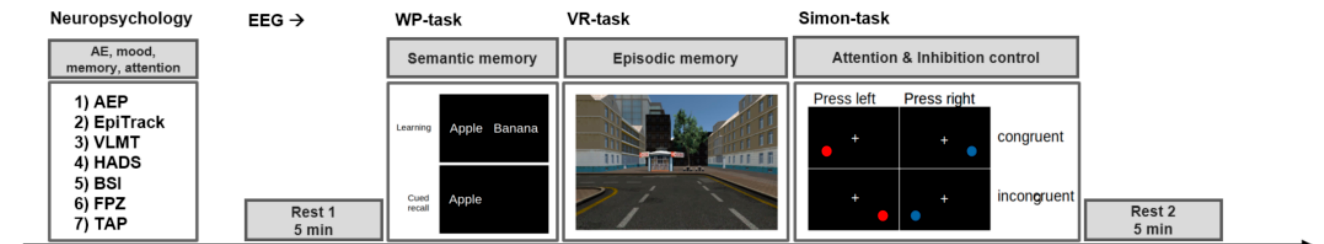
Figure 1. Examination procedure. The examination included a neuropsychological assessment and an EEG recording. During the neuropsychological assessment, the patients were screened for adverse events, mood and psychiatric symptoms, memory, attention, and executive functions. Next, the EEG recordings were conducted starting with a 5 min resting period (Rest 1), followed by three cognitive tasks (semantic memory, episodic memory, attention, and inhibition control), succeeded by a final 5 min resting period (Rest 2). This procedure was conducted for the baseline examination before the medication started, and the same procedure was repeated after 8 weeks treatment with montelukast (using parallel versions of the cognitive tasks). Abbreviations: AE = adverse event, AEP = adverse event profile, VLMT = verbal learning and memory test, HADS = hospital anxiety and depression scale, BSI = Barratt impulsiveness scale, FPZ Fragebogen zur Persönlichkeit bei zerebralen Erkrankungen (clinical personality scales), TAP Thematischer Apperzeptionstest (attention), WP = word-pair learning task, VR = virtual reality-task.